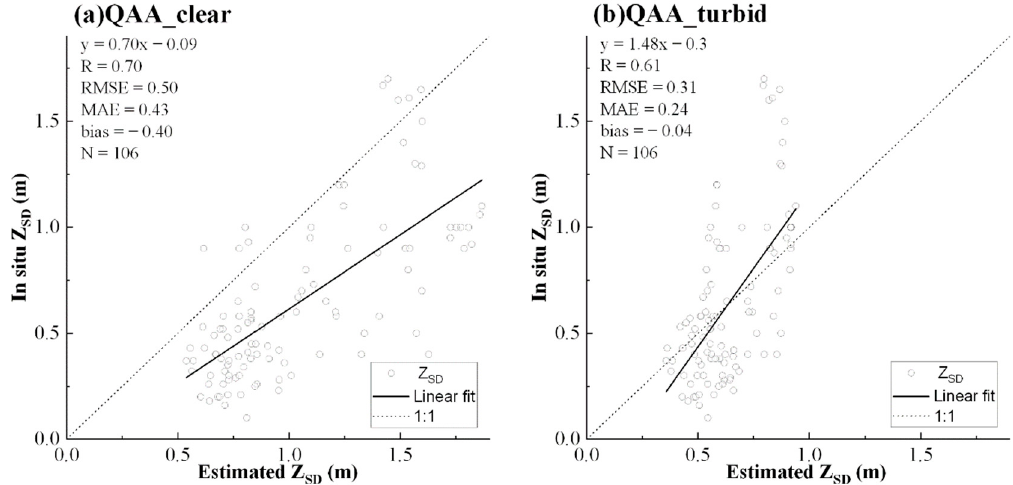
Figure 4. Scatter plots of Landsat-estimated Z SD and in situ-measured Z SD for ( a ) QAA_clear and ( b ) QAA_turbid. The field data were gathered ±1–7 days of Landsat satellite overpass.